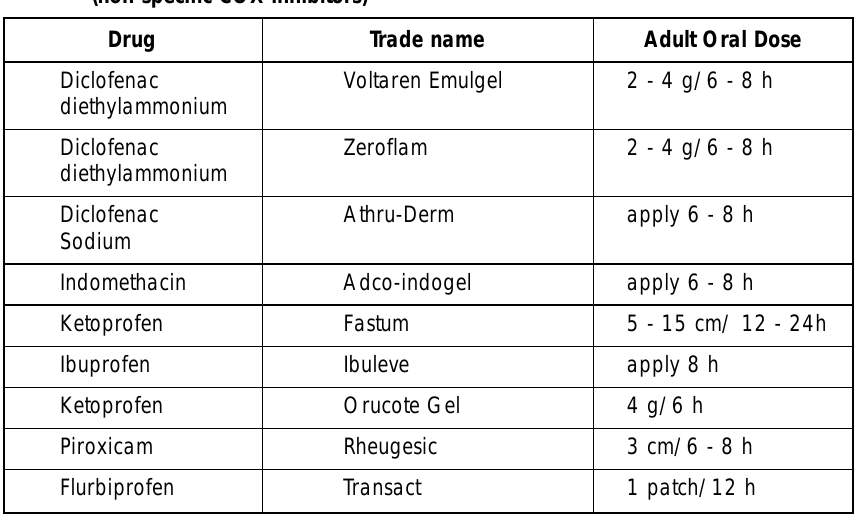
Table 3: Some generic and selected trade names for topical NSAIDs (non-specific COX inhibitors) Drug